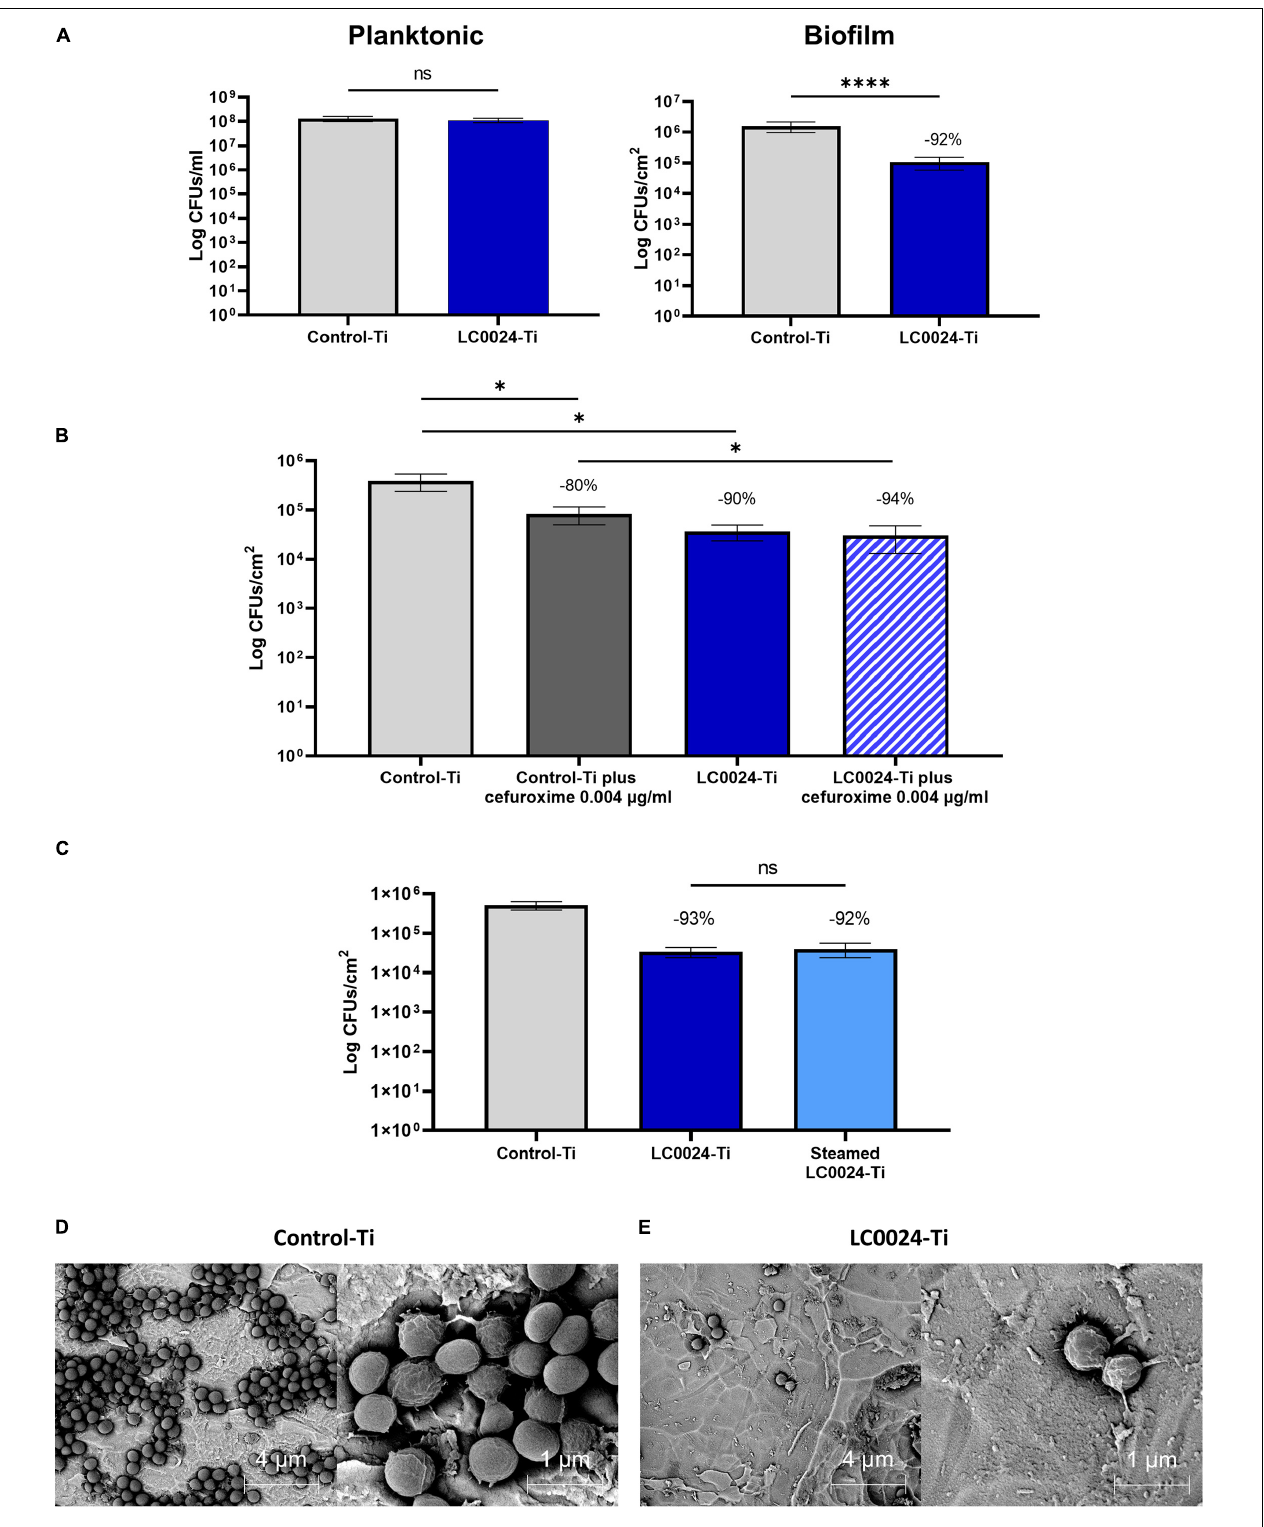
FIGURE 2 | Overview of in vitro activity evaluation. (A) In vitro characterization of planktonic growth and biofilm formation of S. aureus JAR060131 on LC0024-Ti disks. Data represent the mean of at least three independent experiments, the error bars show the standard error of the mean (SE). Statistical significance was determined by applying a two-sided ratio paired t -test using GraphPad Prism (ns, not significant; **** p < 0.0001), the average relative reduction compared to the